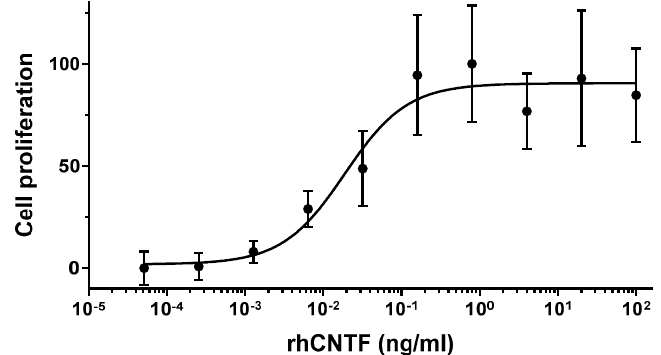
Figure 2. 5-bromo-2’-deoxyuridine (BrdU) incorporation assay analysis of the in vitro biological activity of rhCNTF to support the proliferation of TF-1.CN5a.1 cells. rhCNTF supports the short-term proliferation of TF-1.CN5a.1 cells, with BrdU incorporation into synthesized DNA observed as a proxy for cell proliferation. Each value shown as average mean of three biological replicates ± SD. Data were normalized to highest bioactivity of